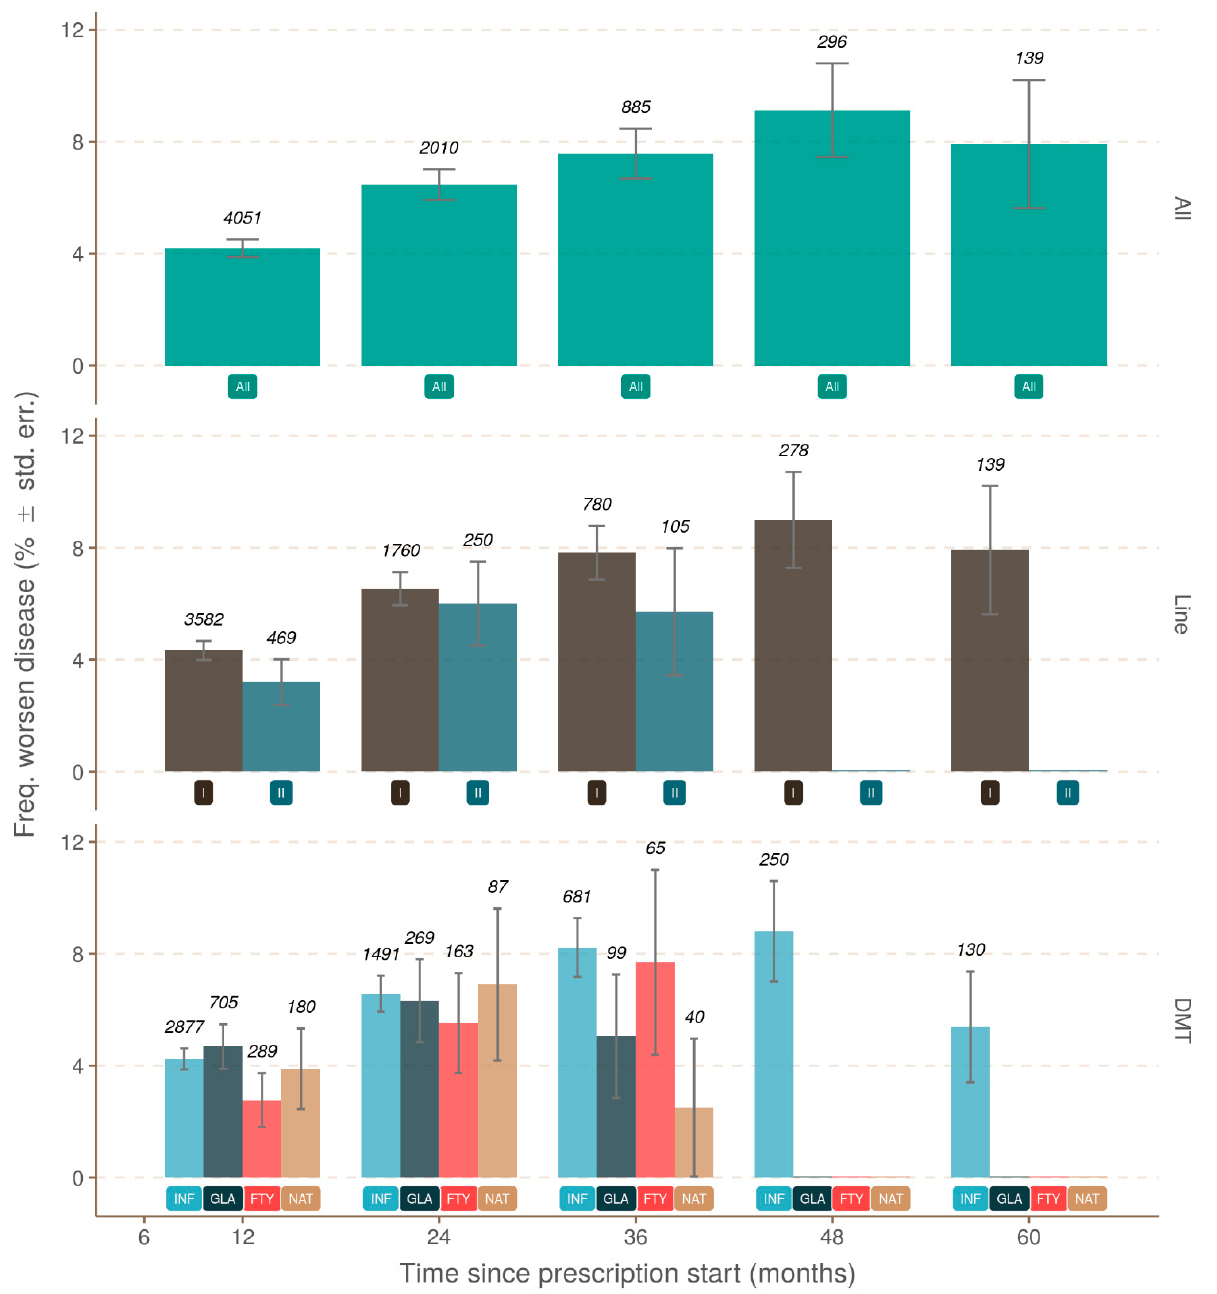
Figure 6. Patients with evidenced disease progression: the proportion of estimations derived from observation of patients never associated with any relapses or brain MRI activity between 12 and 60 months from the prescription start. The upper pane uses the complete set of observations (green; label at y = 1 is “All”), the middle pane uses first- and second-line treatment (label at y = 1; first-line, dark brown; second-line, dark blue), and the lower pane uses the drug (label at y = 1; Fingolimod, red, FTY; Glatiramer Acetate, dark blue, GLA; Interferon, blue, INF; Natalizumab, light brown, NAT). The error bar represents the standard error estimated asp × (1 − p)/ n , with p being the number of positives and n the total number of observations. DMT: disease-modifying therapy.